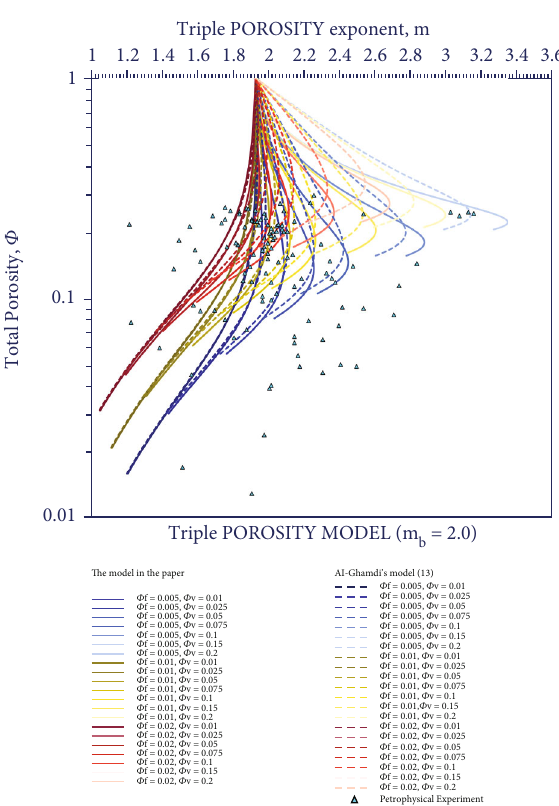
Figure 7: m determined as a function of triple-porosity media reservoirs with matrix pores, fractures, and vugs ( m experimental data comes from Ragland